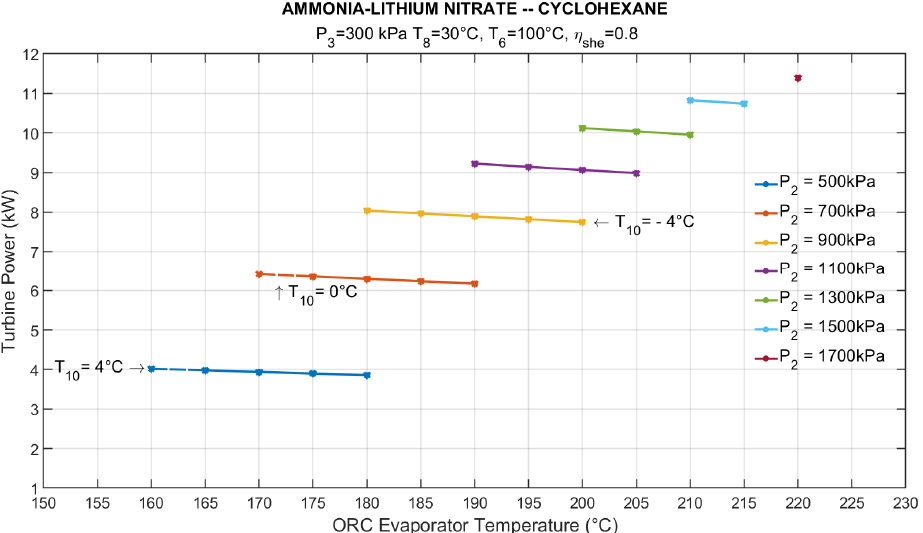
Figure 8. NH 3 -LiNO 3 –C 6 H 12 turbine power as a function of heat supply temperature and cooling temperature at different turbine operating pressures.